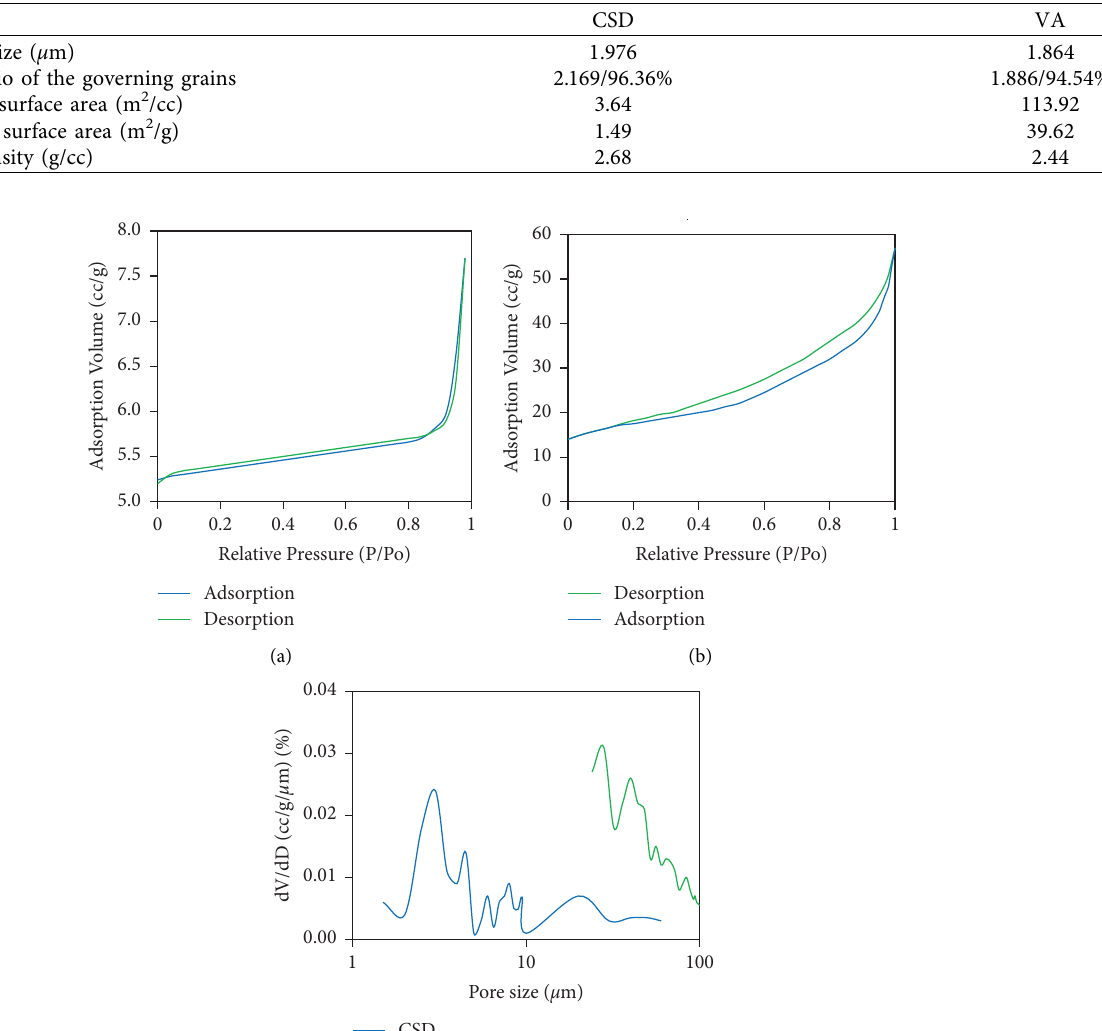
Table 5: Physical properties of CSD and VA.